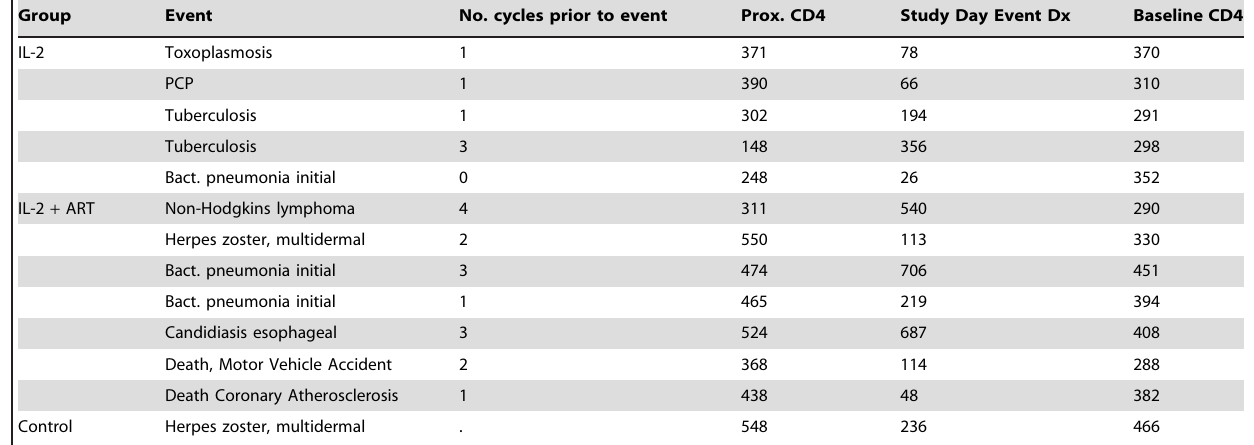
Table 2. Reported disease progression